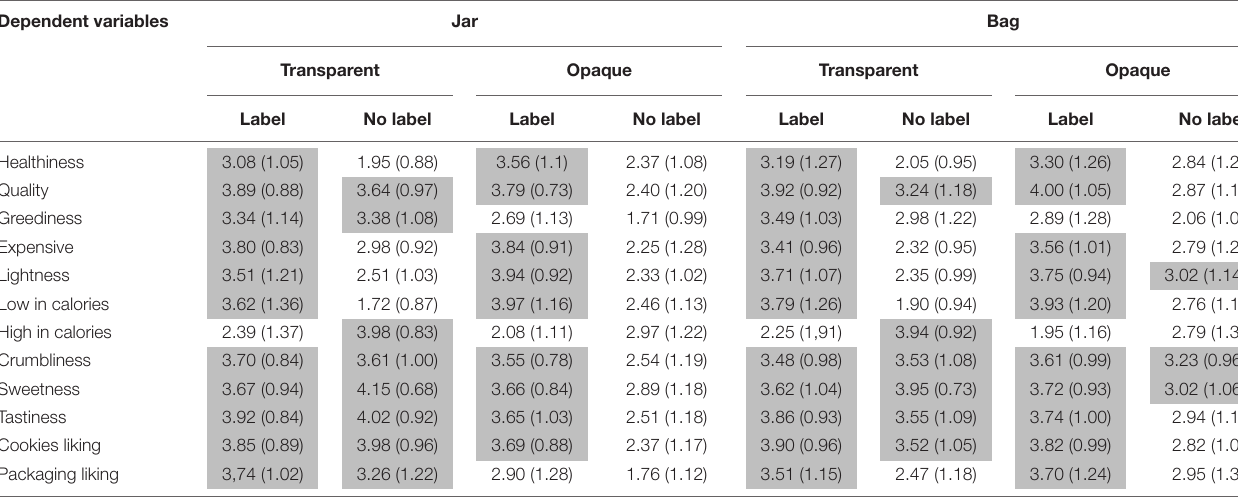
TABLE 2 | Summary of the dependent variable means and corresponding standard deviations (SD) as a function of the eight different packaging presentations. Dependent variables